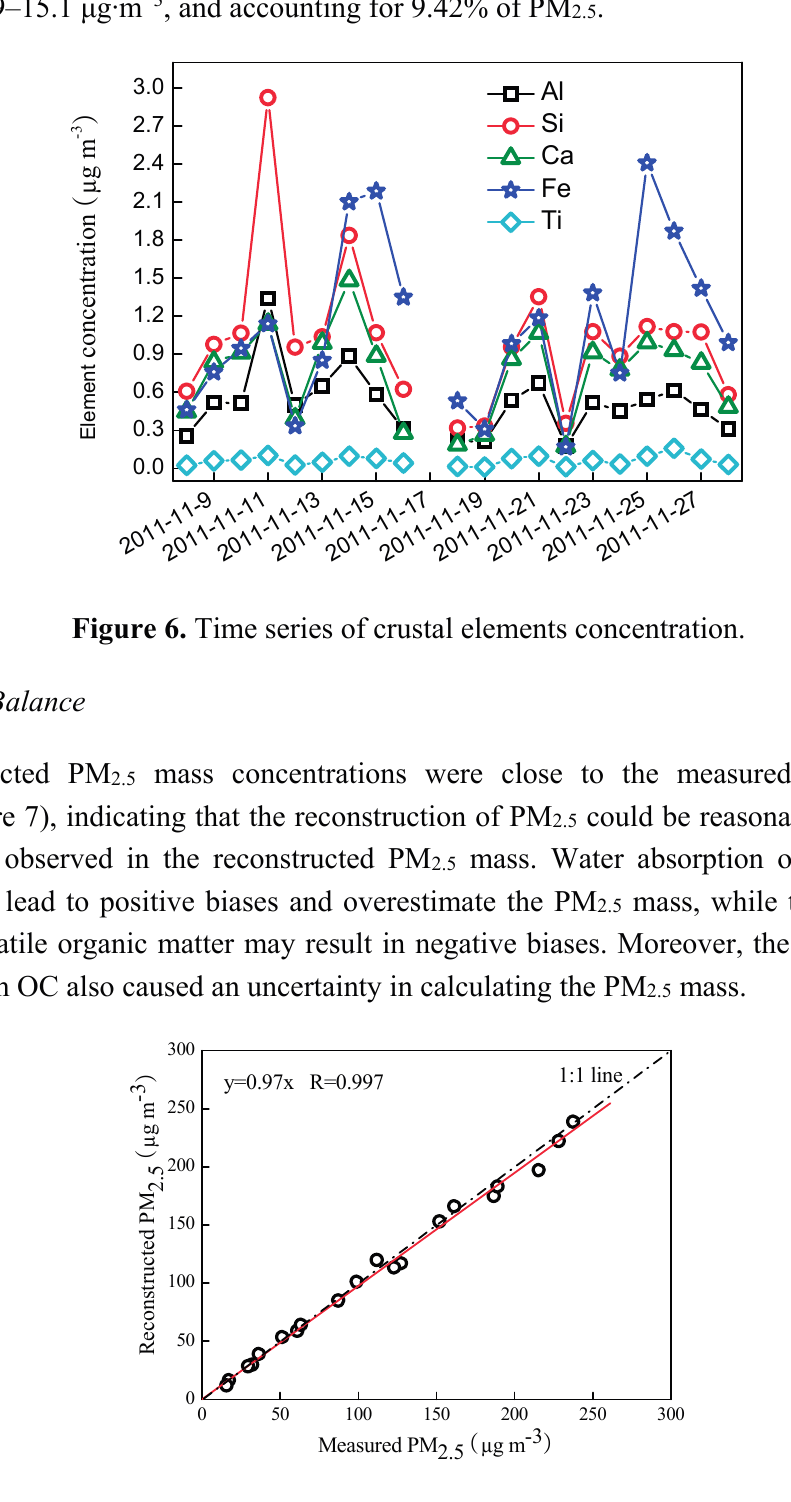
Figure 7. Scatter plots of measured and reconstructed PM 2.5 mass